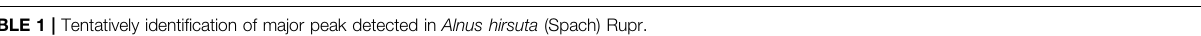
TABLE 1 | Tentatively identi fi cation of major peak detected in Alnus hirsuta (Spach) Rupr. NO. t R (min)